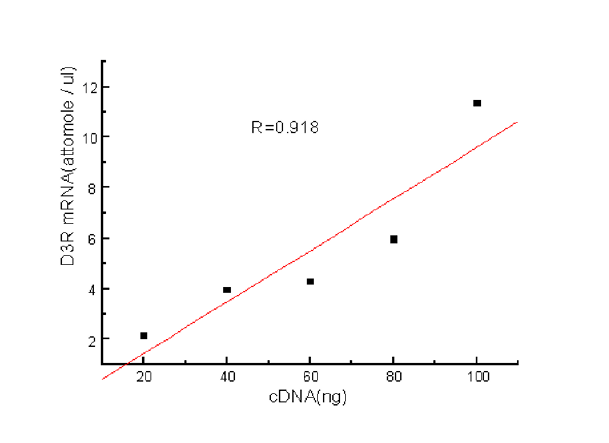
Figure 3 D3R mRNA standard curve. Linear correlation is shown between template cDNA and D3R mRNA. This finding rep- resents the sensitivity and reproducibility of the methodolog- ical technique.